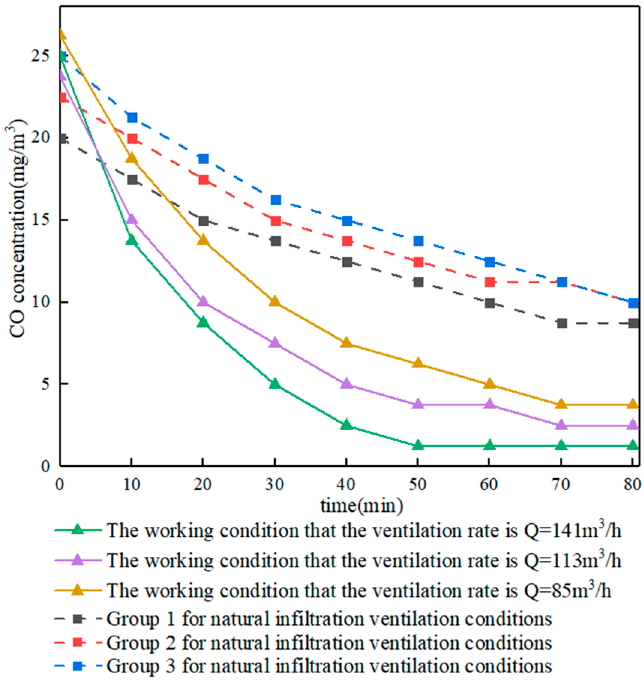
Figure 6. Fresh air dilution experiment results.